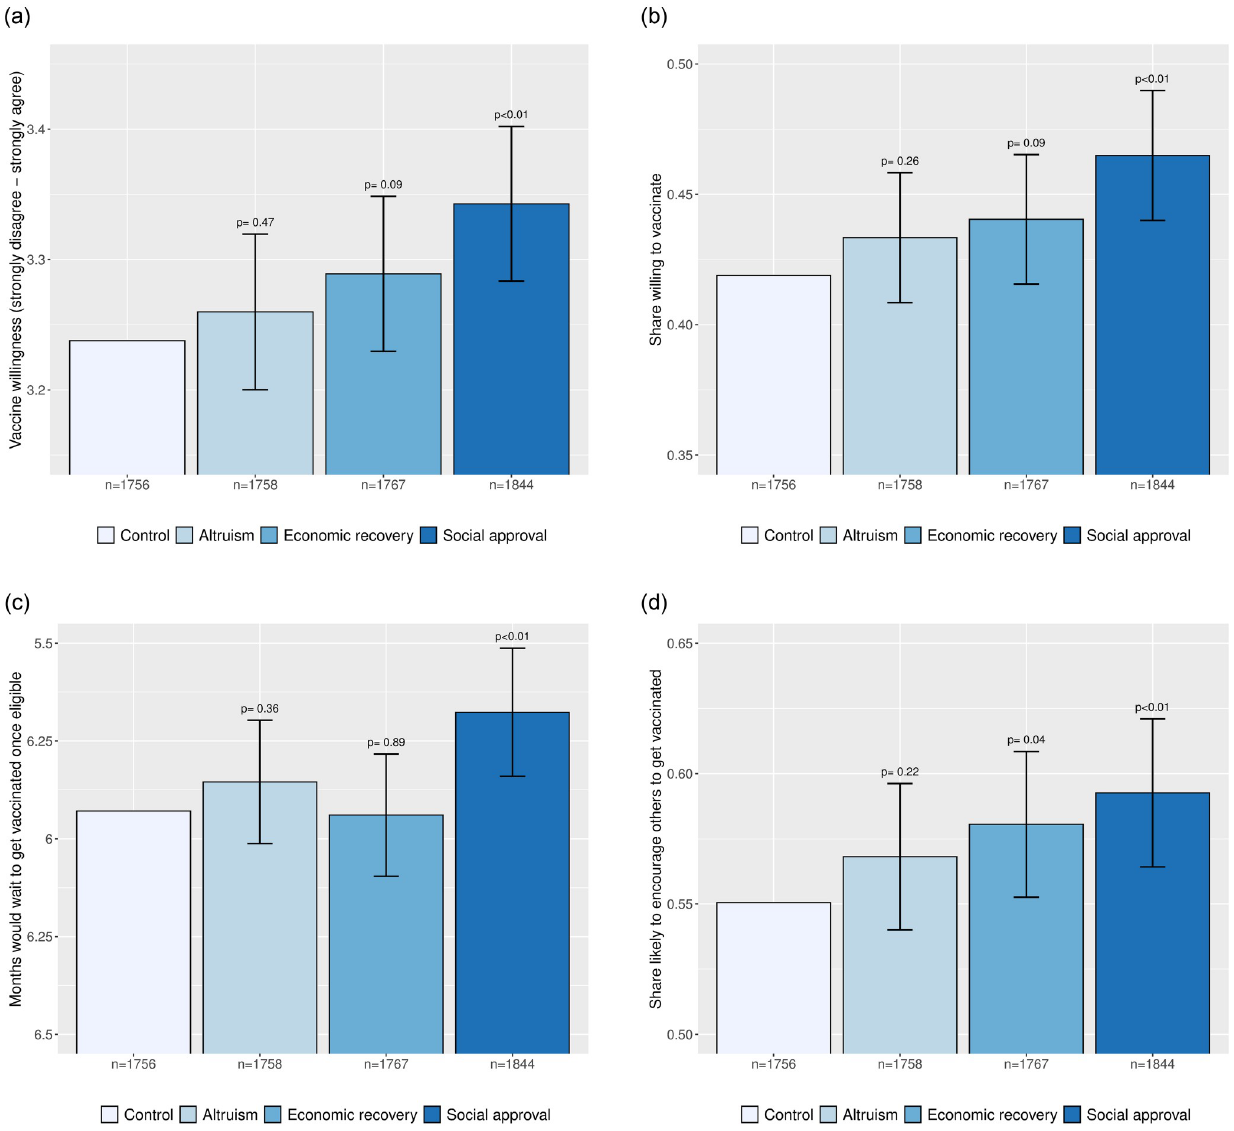
Fig 7. Average effects of motivational messages on vaccine willingness. Each bar depicts a group outcome mean. The outcome in panel (a) is a five-point vaccine willingness scale ranging from “strongly disagree” (1) to “strongly agree” (5); the outcome in panel (b) is an indicator for “agree” or “strongly agree”; the outcome in panel (c) is the (reversed) number of months that a respondent would wait to get vaccinated once eligible for a vaccine; and the outcome in panel (d) is an indicator for a respondent being “somewhat likely” or “very likely” to encourage others to get vaccinated. Error bars denote 95% confidence intervals for treatment effects relative to the control group; the associated p values are from two-sided t tests. The underlying regression specifications for each outcome are described in S3 Appendix and the underlying regression table is reported in S6